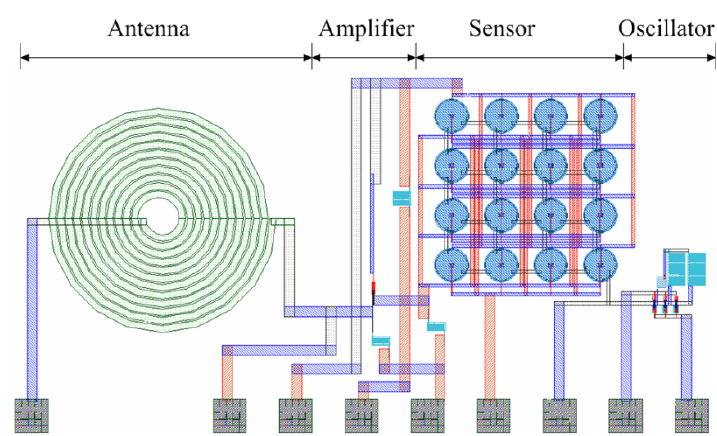
Figure 1. Layout of the wirless pressure